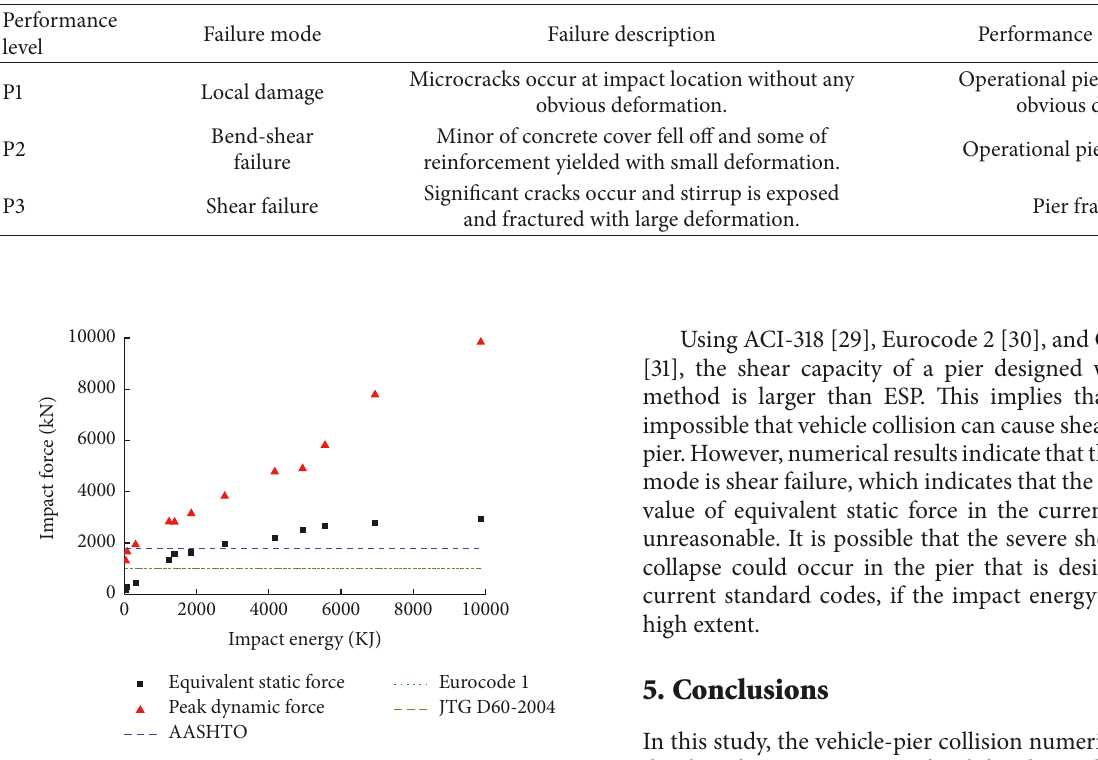
Figure 24: Comparison among the design impact force, the peak impact force, and the equivalent static